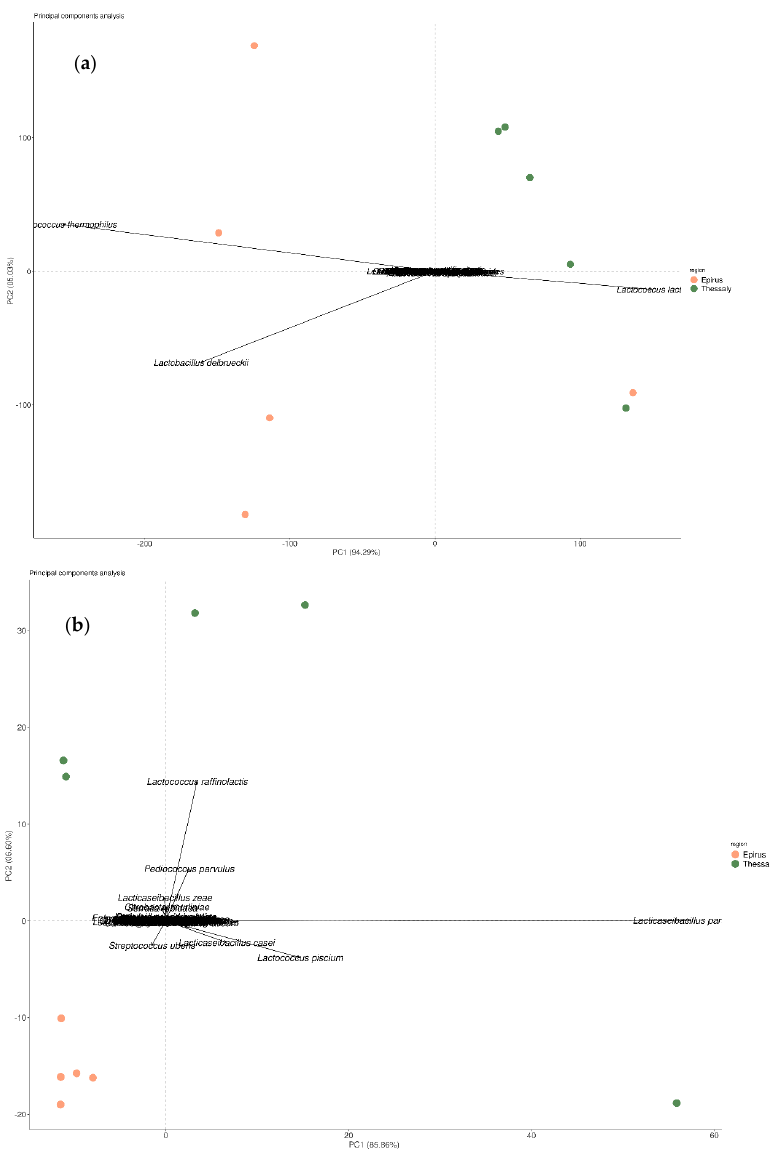
Figure 5. Principal component analysis (PCA) plot of the two first principal components. ( a ) PC1 explains 94.29% of the data variance and PC2 explains 5.03% of the variance when all the species are included in the analysis; ( b ) PC1 explains 85.86% of the data variance and PC2 explains 6.60% of the variance after the three major species are removed from the